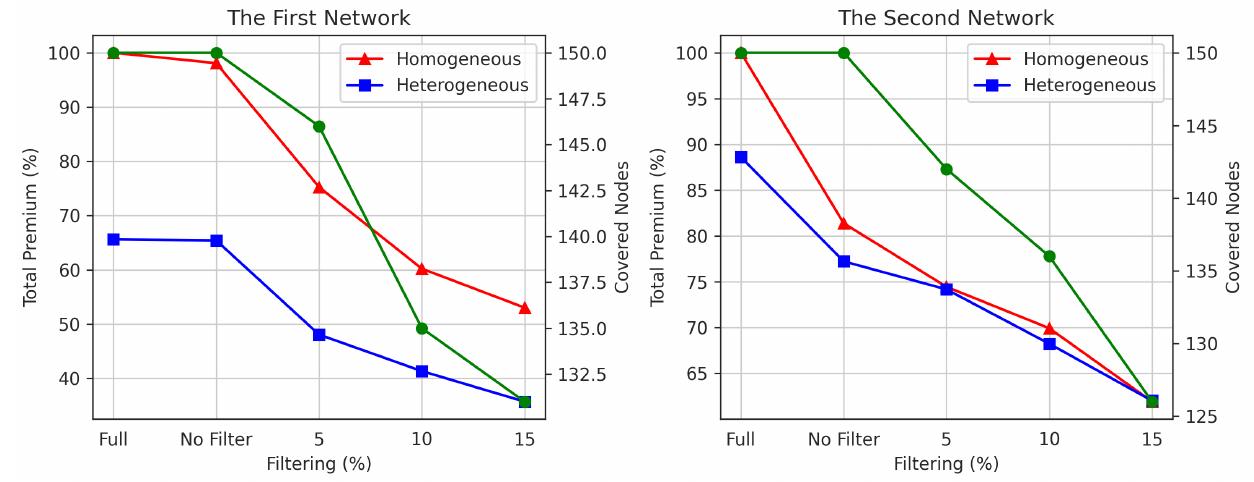
Figure 16. Comparison of homogeneous total premium ( ), heterogeneous total premium ( ) and covered nodes ( ) in the first and second network for two cases: (1) without GMA (Full), and (2) with GMA (using filter 0% (No Filter), 5%, 10%, 15% and